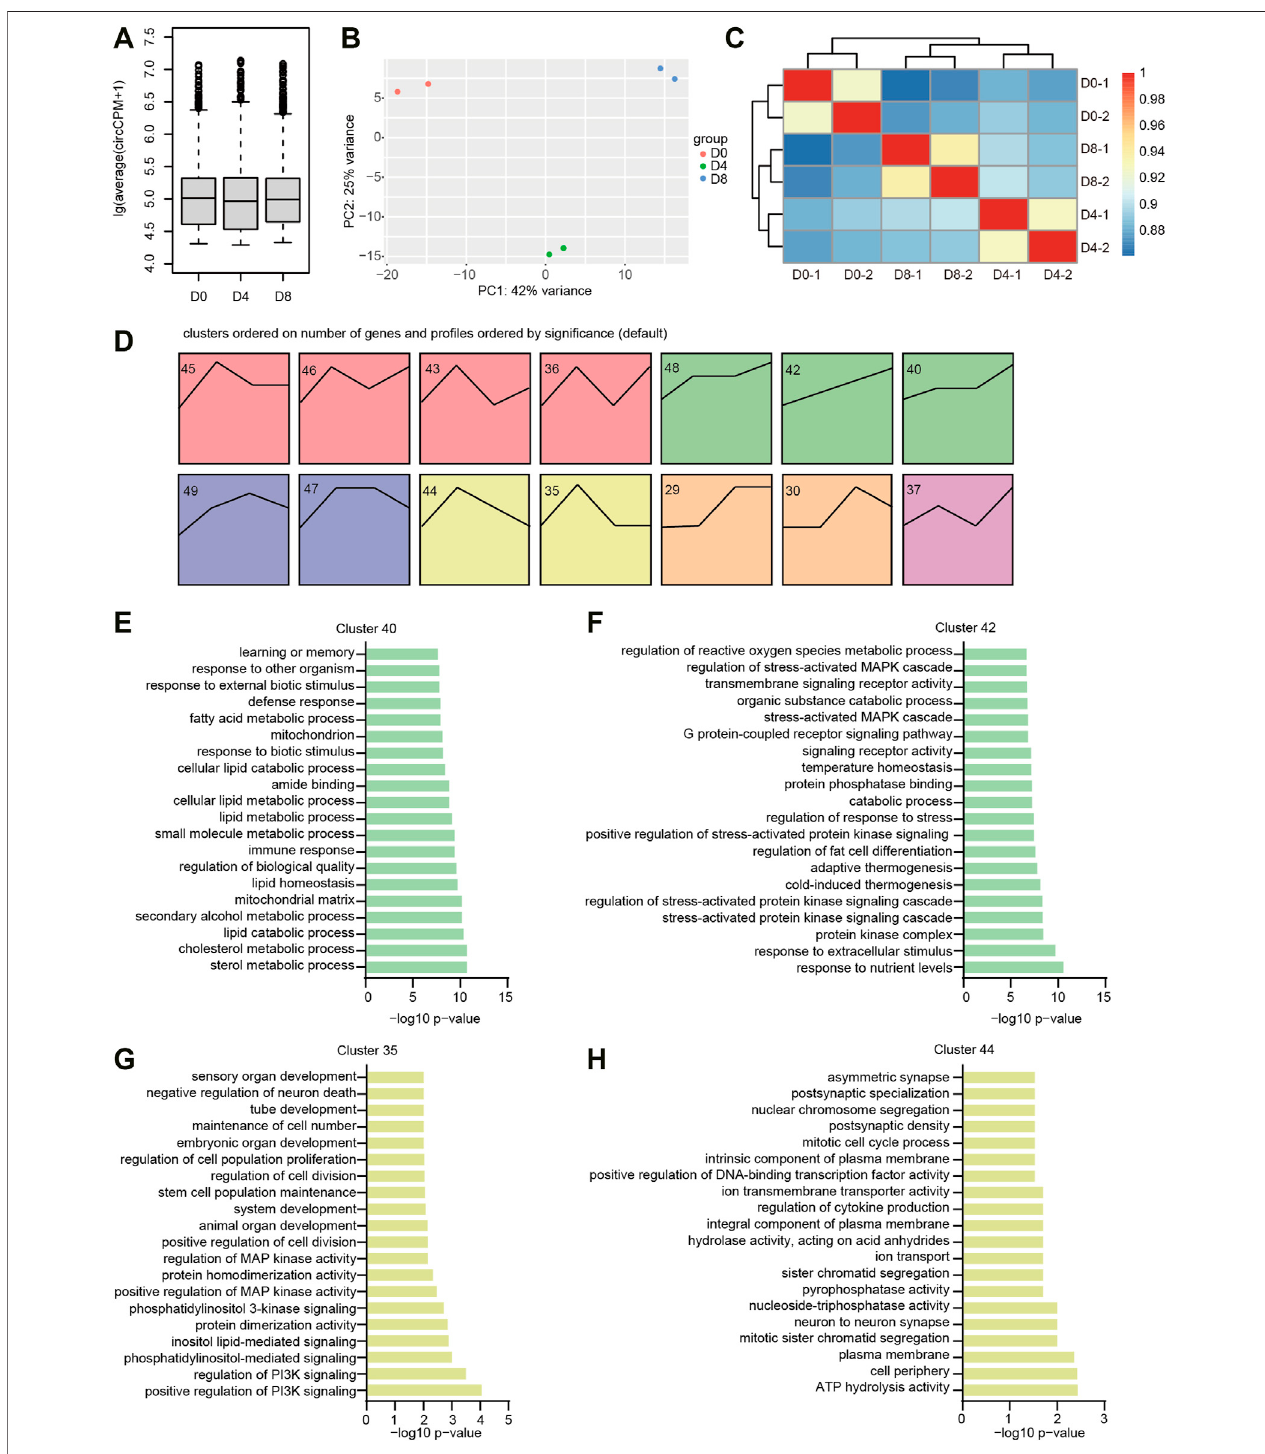
FIGURE3| TheexpressionpatternsofcircRNAduringbrownadipogenesis. (A) RelativeexpressionlevelsofcircRNAsduringbrownadipogenesis. (B) PCAplotof circRNAexpressionduringbrownadipogenesis. (C) CorrelationofcircRNAexpressioncalculatedbyDESeq2rlog-normalizedRNA-seqdata. (D) Timeseriesanalysisof circRNA expression patterns. The number on the top left indicated the expression pro fi le number. (E – H) GO terms enriched for the host genes of indicated circRNA clusters.